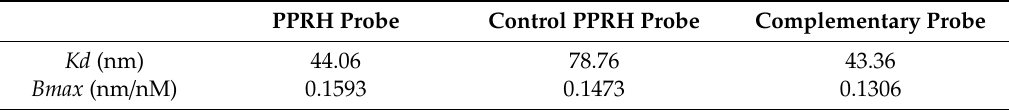
Table 2. Kinetics parameters, equilibrium binding constant ( Kd ) and extrapolated maximum number of bioreceptors in the surface ( Bmax ), corresponding to the hybridization interaction mtLSU rRNA